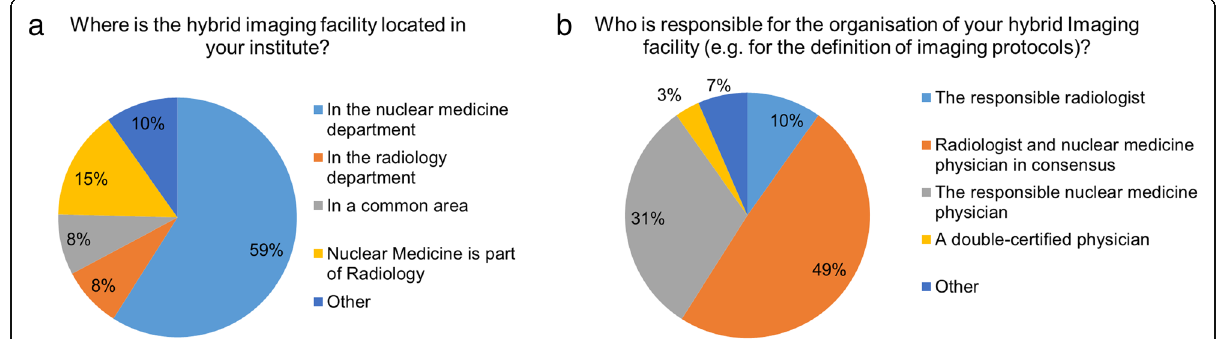
Fig. 1 ( a ) Location of and ( b ) responsibility for hybrid imaging